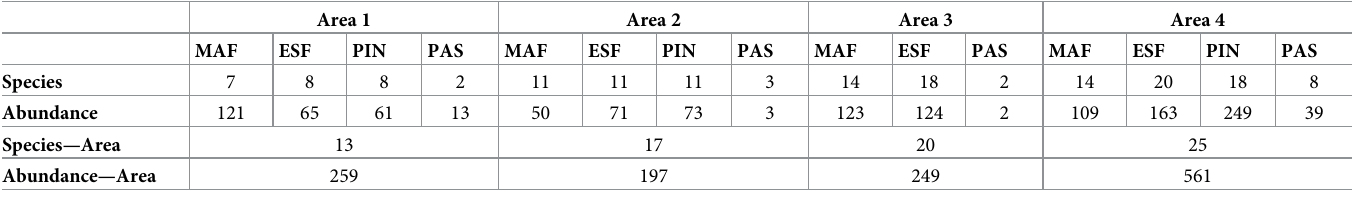
Table 1. Richness and abundance in four study areas in the municipalities of Bom Retiro (area 1 and 2) and Rancho Queimado (area 3 and 4), in the state of Santa Catarina, Brazil.